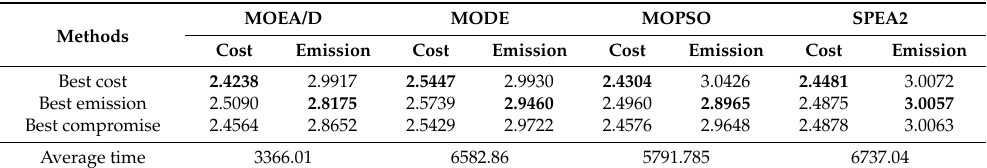
Table 3. The solutions and average computation time (seconds) of different methods. (Cost ( × 10 6 ) and Emission ( × 10 5